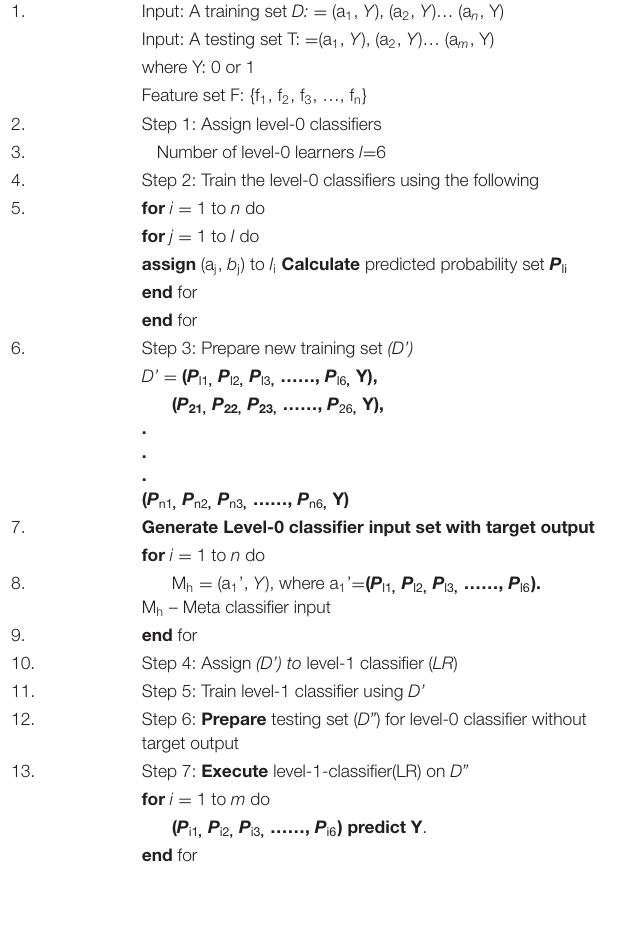
ALGORITHM 1 | Algorithm Stacked